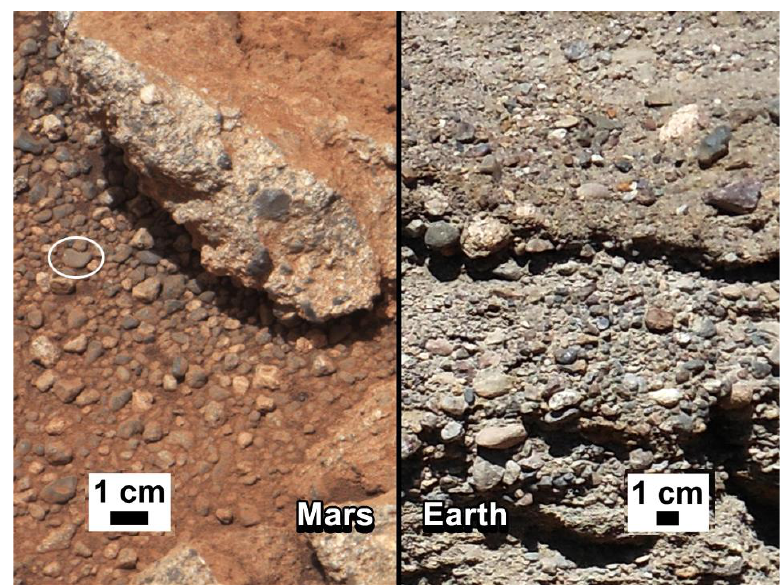
Figure 23. Rock outcrop on Mars — compared with a terrestrial fluvial conglomerate — suggesting water “ vigorously ” flowing in a stream [113 – 115].